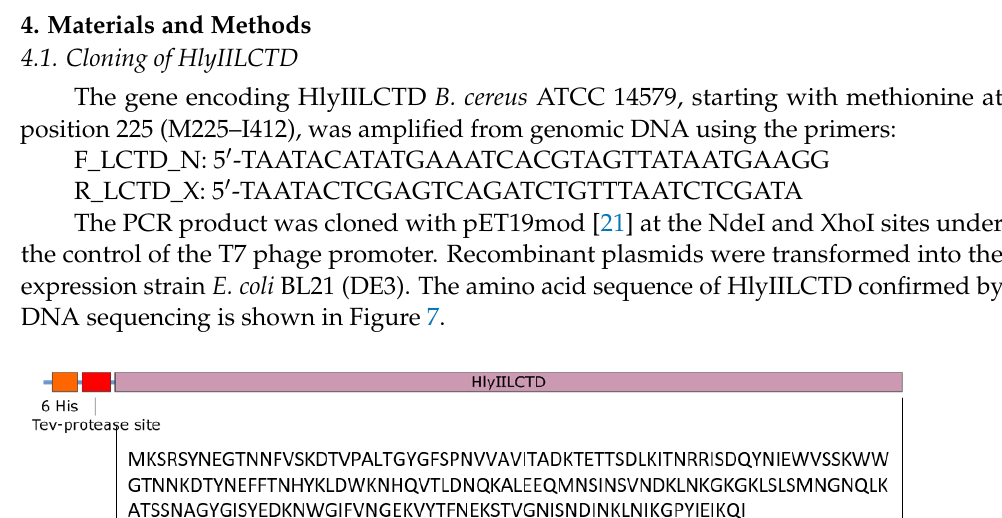
Figure 6. Proposed schemes of erythrocyte agglutination. ( A ) Agglutination can occur due to the binding of the N-terminal region of HlyIILCTD to the surface of erythrocytes and the oligomerization of the C-terminal region of HlyIILCTD. ( B ) Agglutination can occur because of the binding to the surface of both the N-terminal and C-terminal regions of HlyIILCTD.